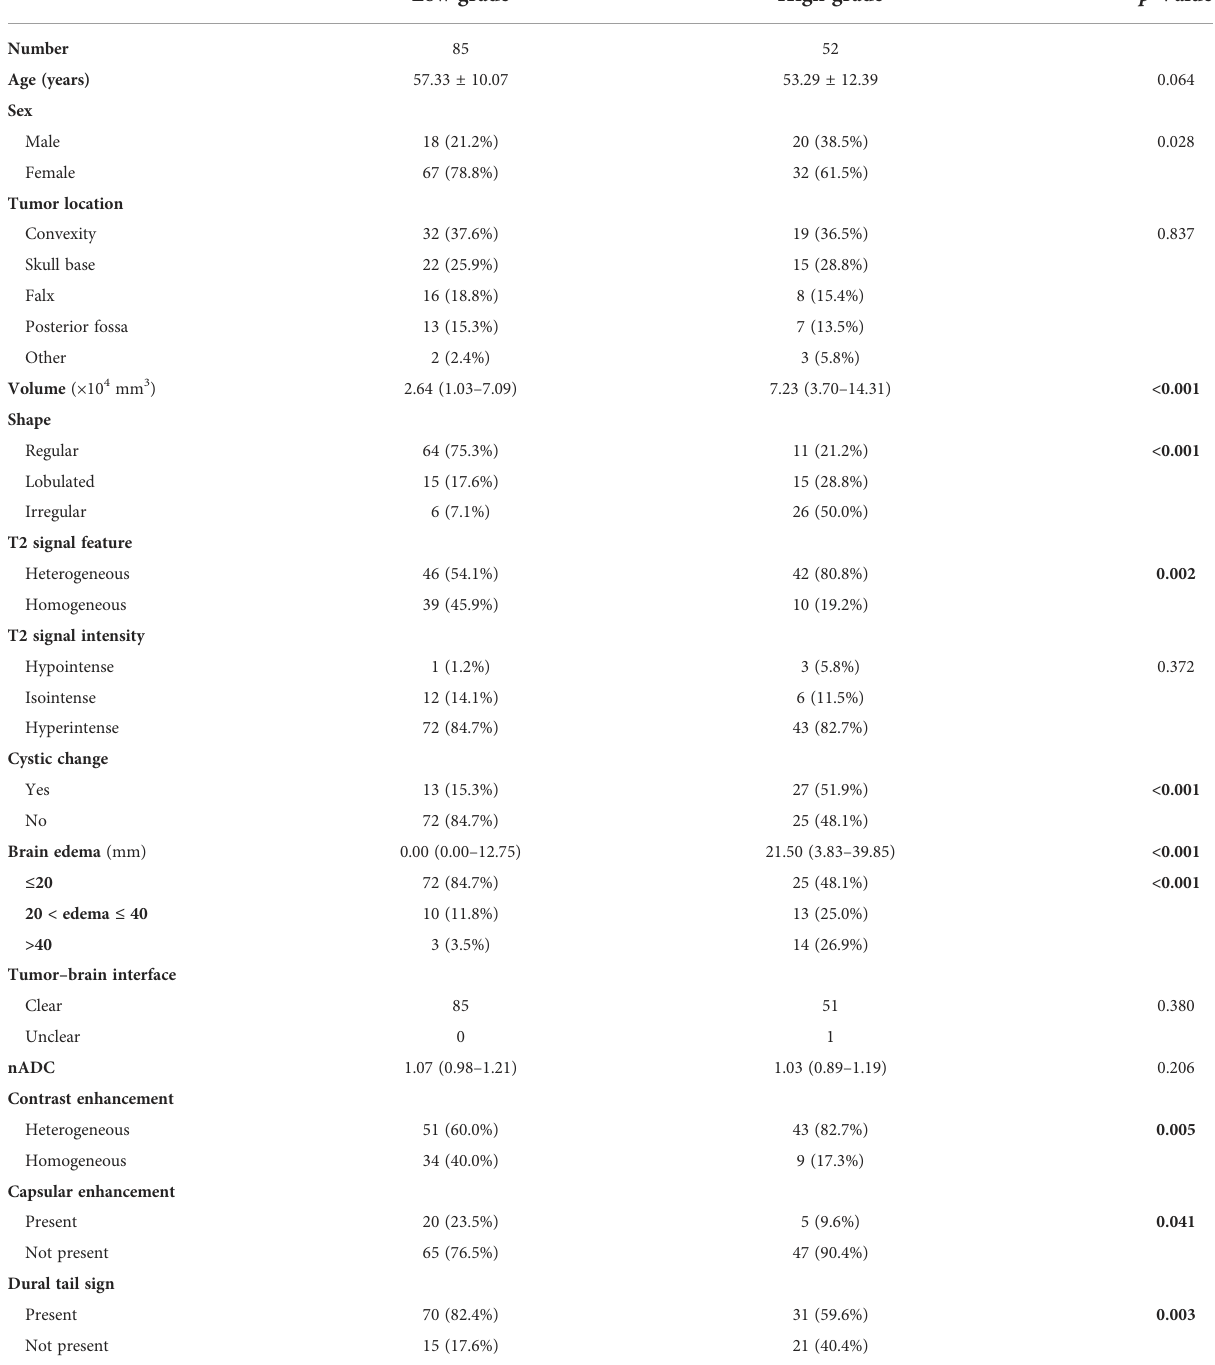
TABLE 3 Demographic and radiological characteristics in the development